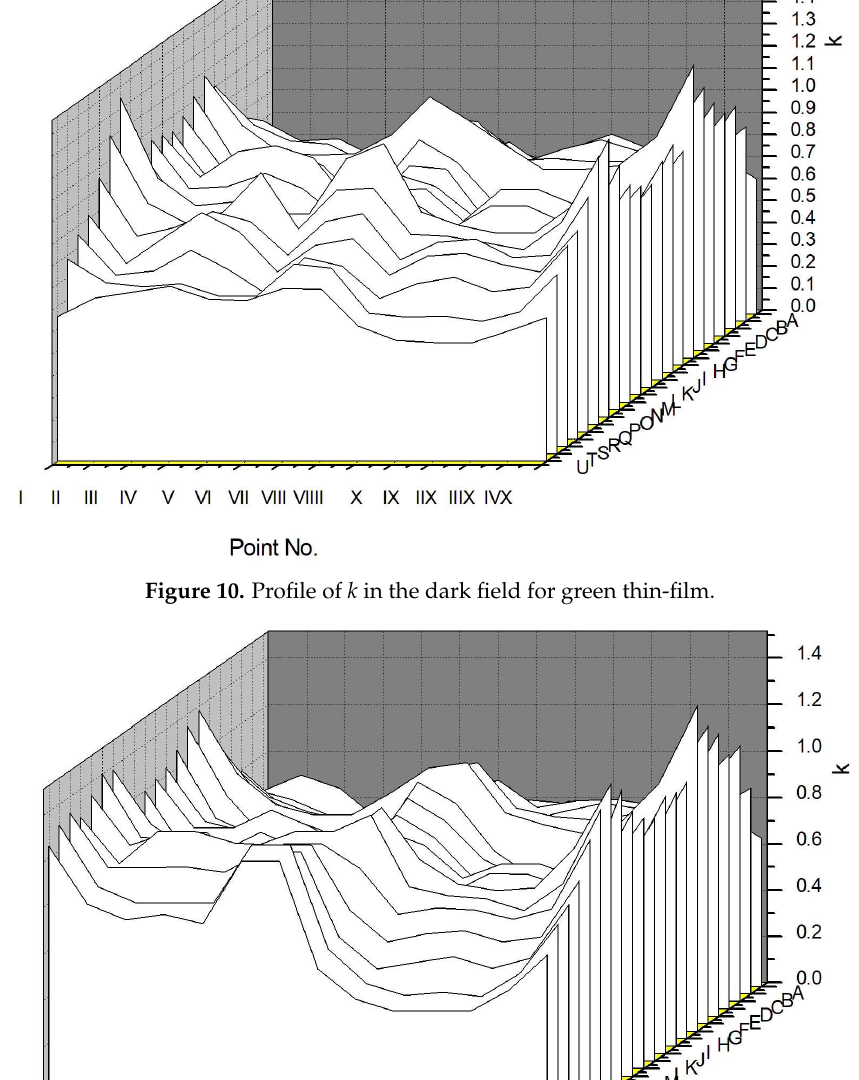
Figure 9. Profile of k in the dark field for red thin-film.